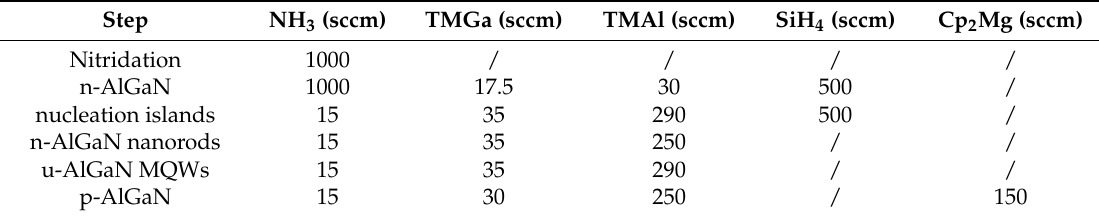
Table 1. The gas flow rate of precursors and dopants for all the MOCVD processes. Step NH 3 (sccm) TMGa (sccm) TMAl (sccm) SiH 4 (sccm) Cp 2 Mg (sccm) Nitridation 1000 / / / / n-AlGaN 1000